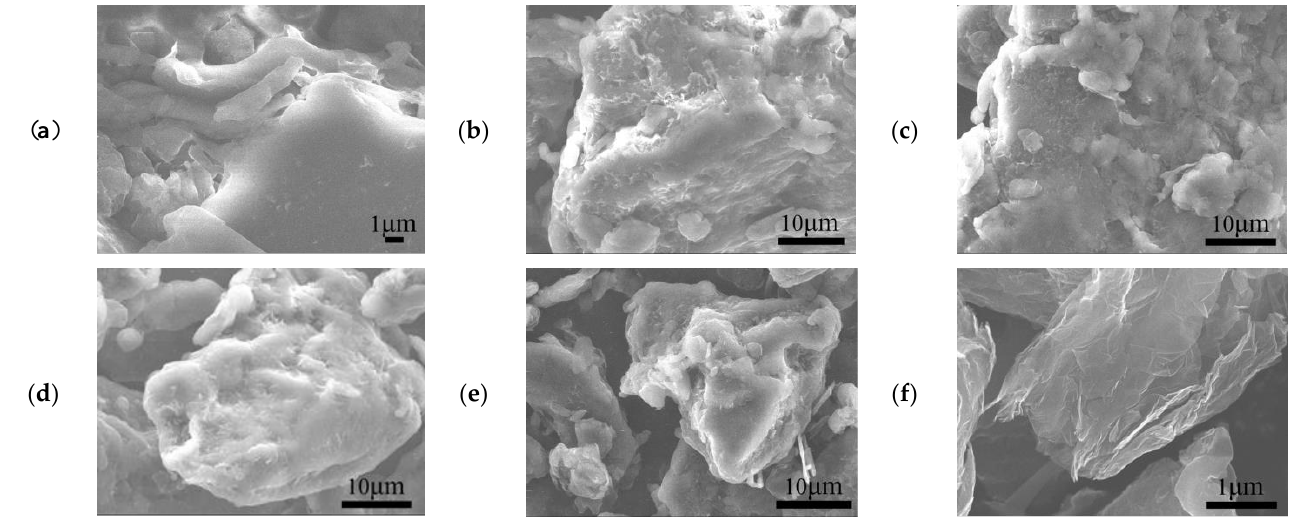
Figure 13. SEM diagram of A 1 ~A 6 composite powders: ( a ) 5% SG/PLA/TPU; ( b ) (4% SG + 1% GR)/PLA/TPU; ( c ) (3% SG + 2% GR)/PLA/TPU; ( d ) (2% SG + 3% GR)/PLA/TPU; ( e ) (1% SG + 4% GR)/PLA/TPU; ( f ) 5% GR/PLA/TPU.